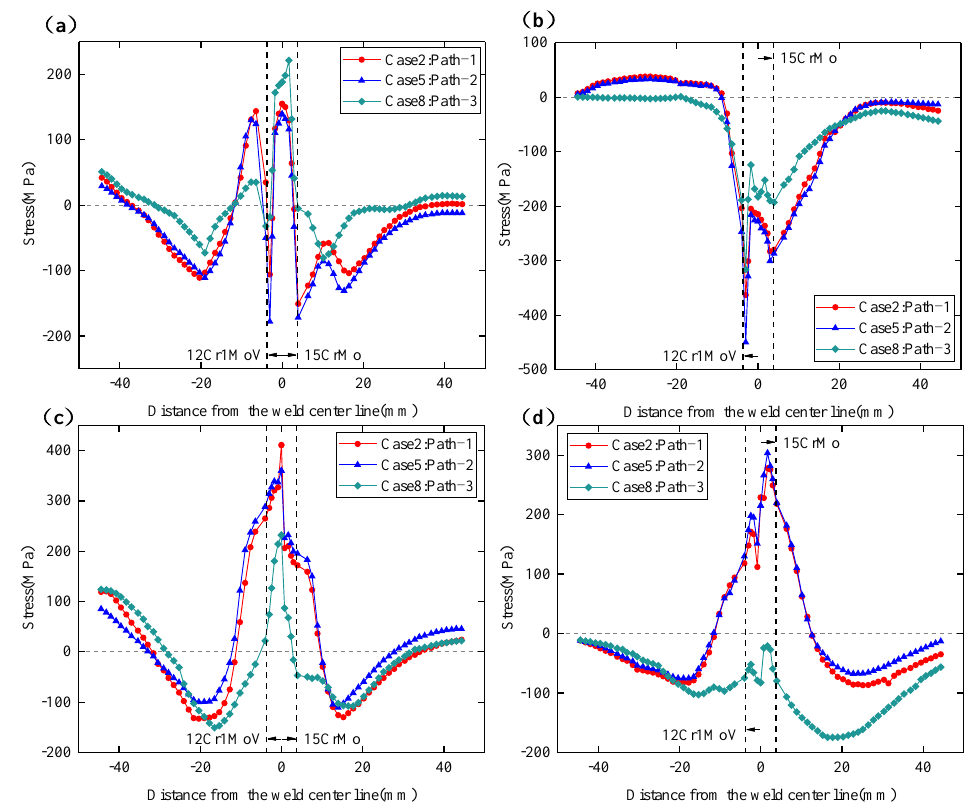
Figure 17. Circumferential and axial residual stress distribution of Case 2, Case 5 and Case 8 at 270° section. ( a ) Circumferential residual stress on the outer surface. ( b ) Axial residual stress on the outer surface. ( c ) Circumferential residual stress on the inner surface. ( d ) Axial residual stress on the inner surface.